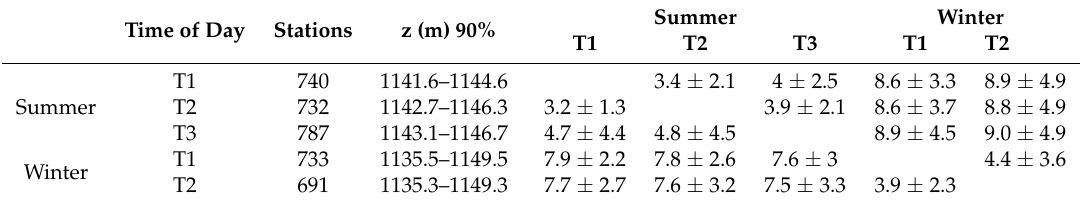
Table 2. Number of camera stations processed per spectral band, range of camera station elevations (90% of all cameras) for each project in Australian Height Datum (AHD) and average 3D distance to the nearest camera station ( ± 1 SD) for all monitoring